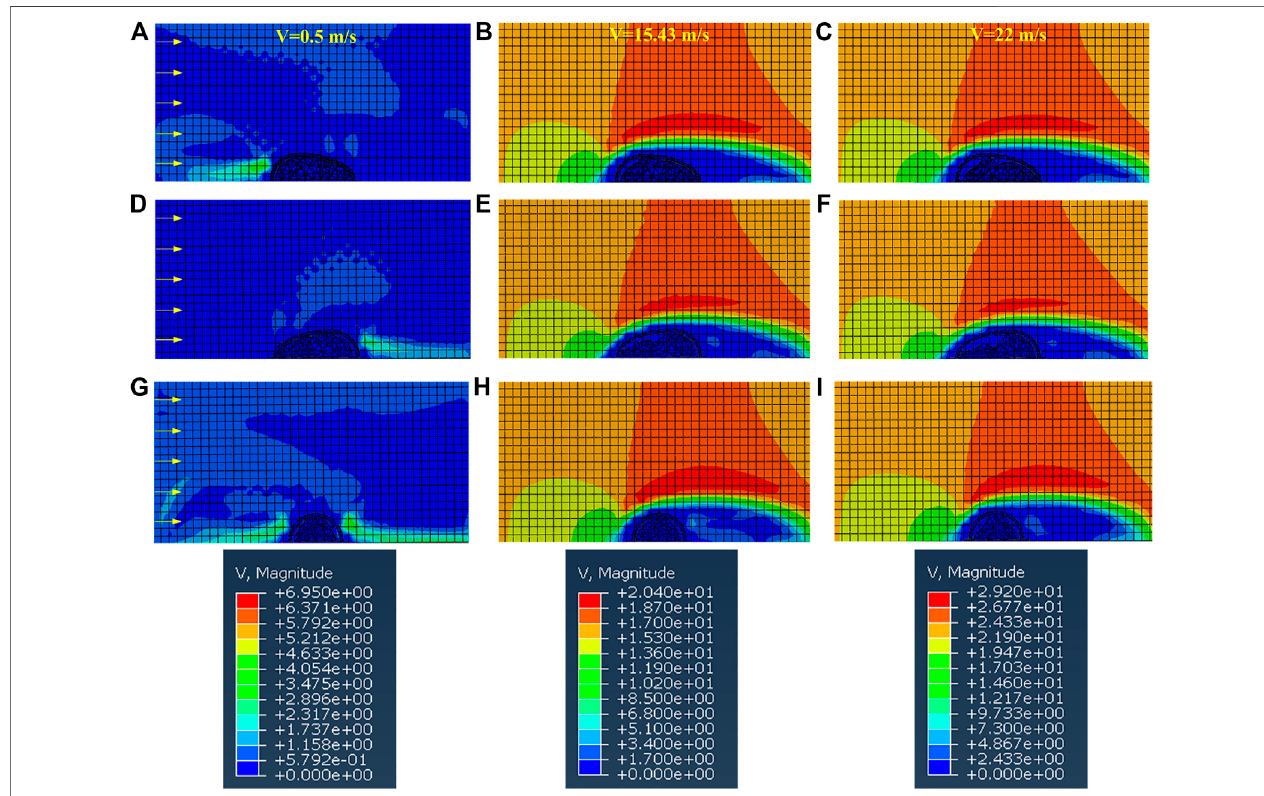
FIGURE 4 | The cloud diagram of the velocity fi eld when the abalone faces the water fl ow with (A – C) posture 1 (D – F) posture 2 (G – I) posture 3.